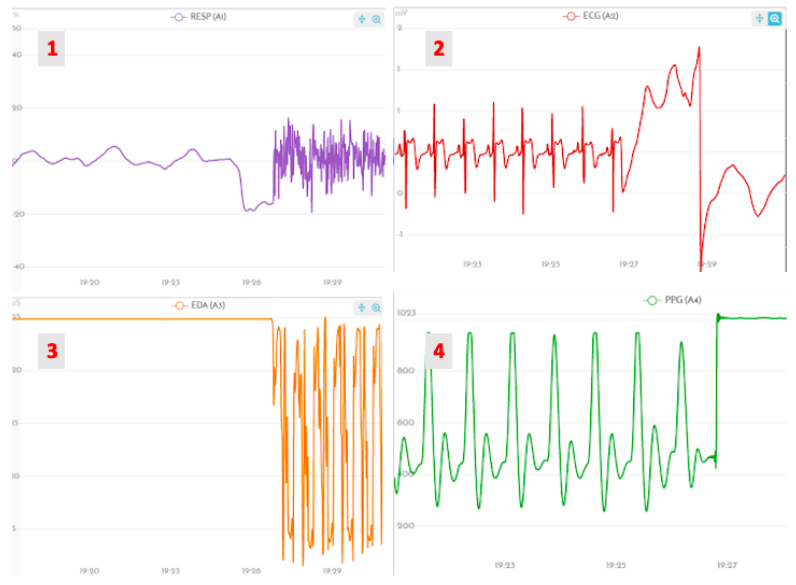
Figure 4. Examples of outlier waveforms obtained for ( 1 ) PZT, ( 2 ) ECG, ( 3 ) EDA, and ( 4 ) PPG